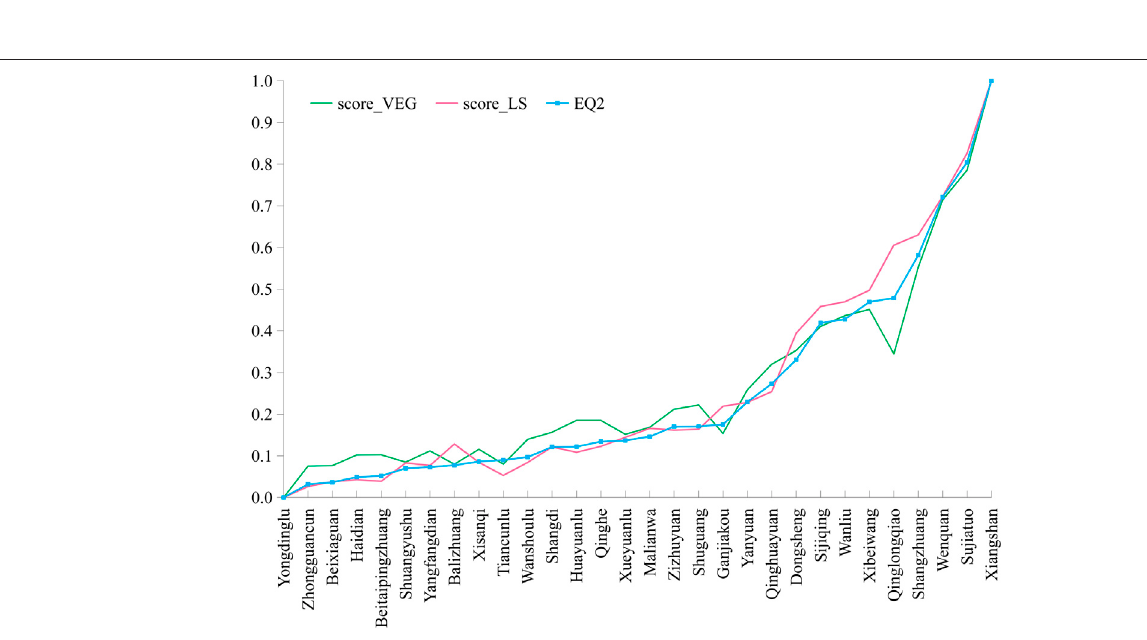
Frontiers in Environmental Science |